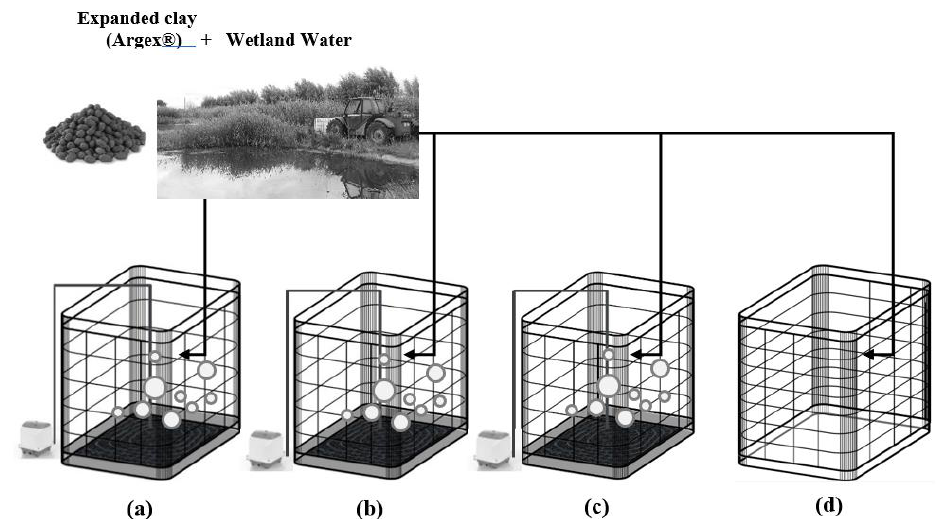
Figure 1. Schematic representation of the operating batch mode intermediate bulk containers (IBCs) used to test the e ff ect on inorganic (TN, NO 3 − , NH 4 + ) and organic (chemical oxygen demand (COD), biological oxygen demand (BOD)) chemical concentrations subjected to di ff erent aeration rates: ( a ) constant aeration, ( b ) 4 h period with aeration followed by 4 h without aeration, ( c ) 6 h period with aeration followed by 4 h without aeration, ( d ) absence of artificial aeration. Approximately 90% of each IBC capacity was filled with expanded clay and 400 L of influent wetland water.